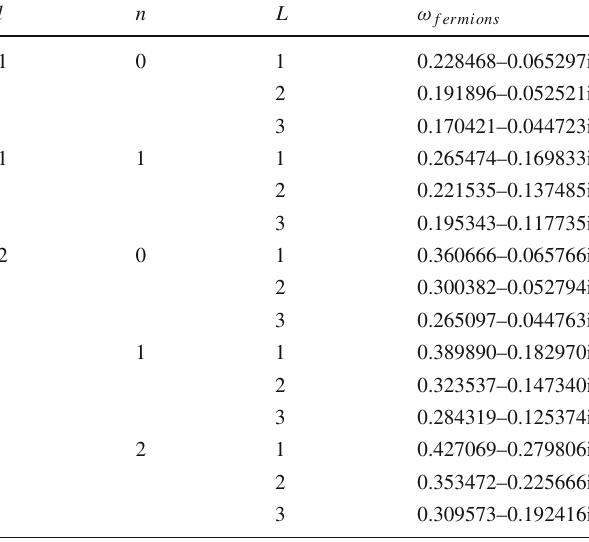
Table 2 QNMs of Dirac waves in the Kerr-like black hole